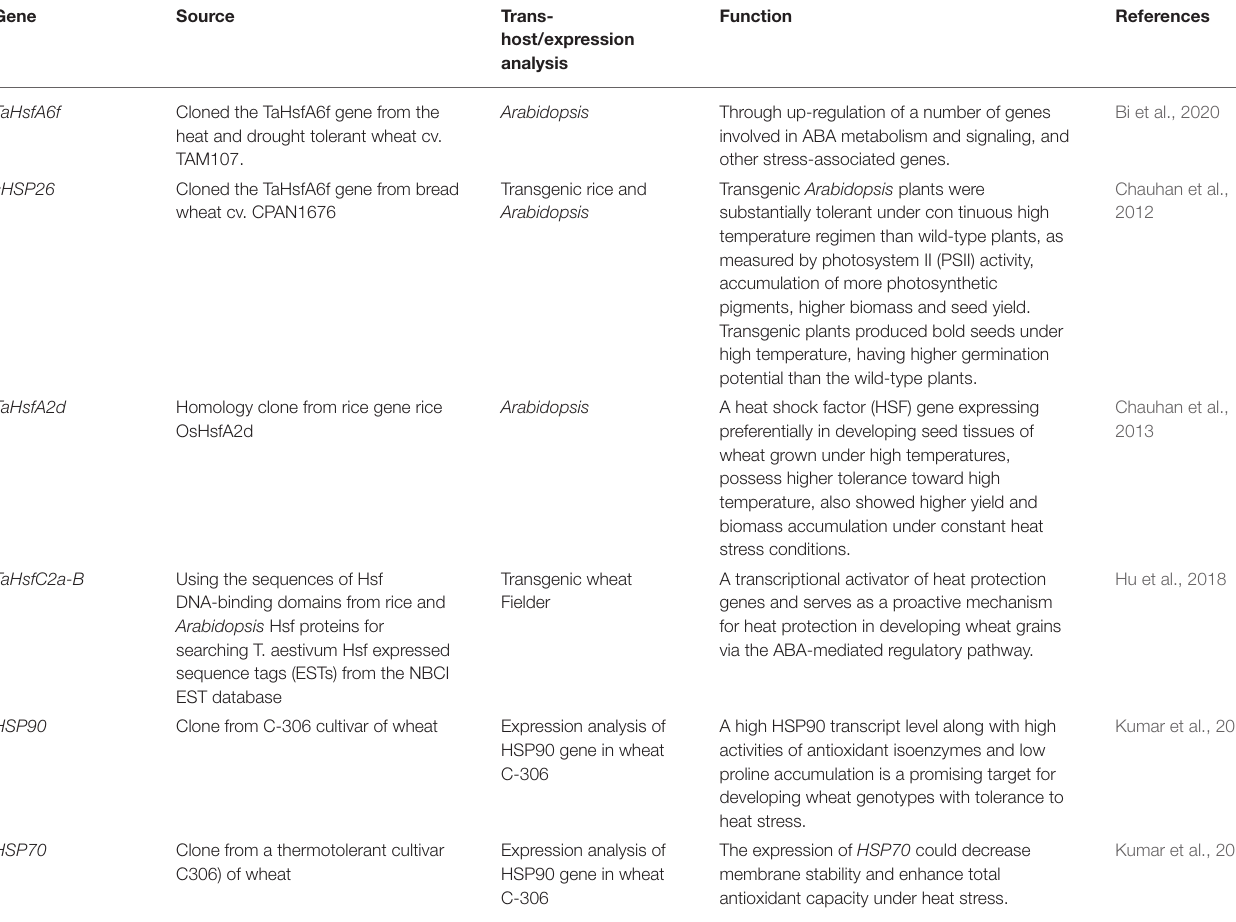
TABLE 2 | Heat shock protein genes involved in sensing and response to heat stress. Gene Source Trans-